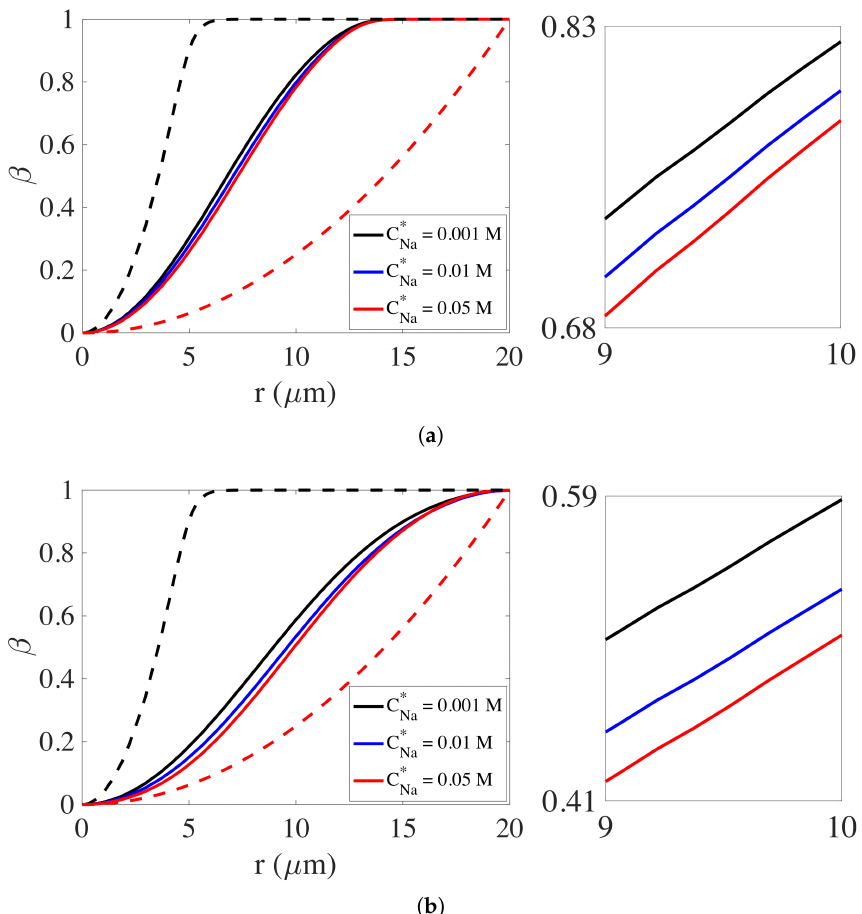
Figure 4. The cumulative network volume fraction function β ( r ) , defined in Equation (65), for = 0.001 M, 0.01 M, and 0.05 M. The dashed black curve is for the initial simulations with C ∗ Na profile. The dashed red curve is for a uniform distribution of network in a disk of radius 20 µ m. ( a ) t = 0.32 ms. ( b ) t = 0.56